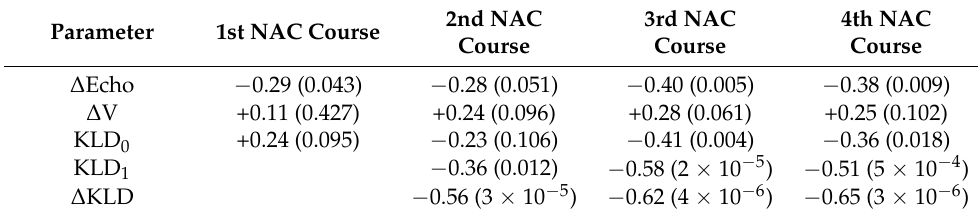
Table A1. Spearman correlations and p -values for assessed parameters after first: second, third and fourth courses of NAC.